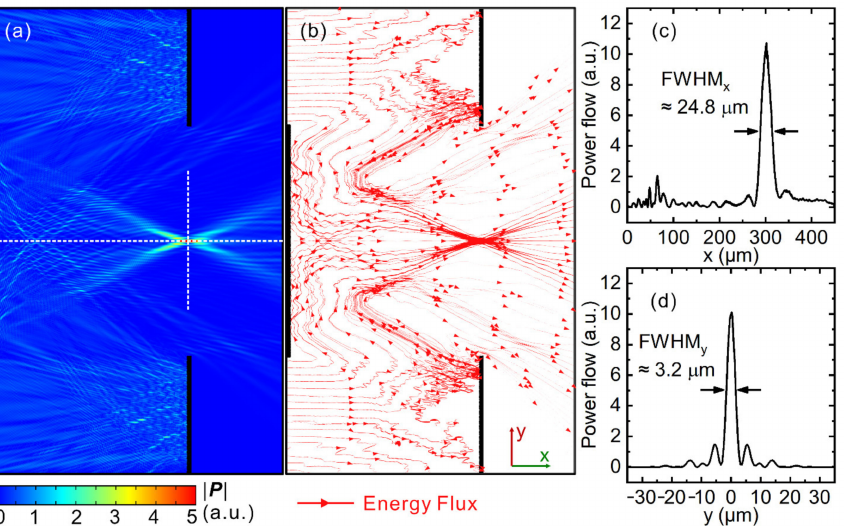
Figure 3. ( a ) Energy flux of a typical metasurface Cassegrain telescope with design parameters R 1 = R 2 = 180 µ m, R 3 = 360 µ m and h = f = 300 µ m. ( b ) Poynting vectors showing that the metasurface conjunction redirects incident energy flux in the way a Cassegrain telescope does. ( c , d ) Line-cut plots of energy flux along the white dashed lines in ( a ) along ( c ) x- and ( d ) y-direction,